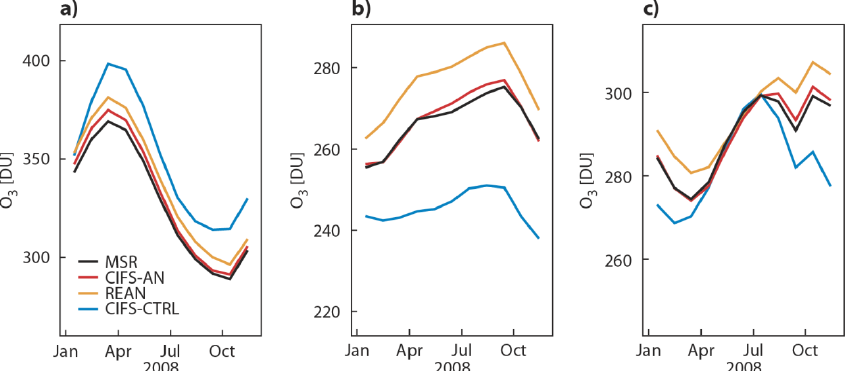
Figure 12. Time series for 2008 of the mean TCO3 of CIFS-AN (red), CIFS-CTRL (blue), REAN (orange) and the multi sensor reanalysis (black) in DU averaged over the (a) NH extratropics (30–90 ◦ N), (b) tropics (30 ◦ S–30 ◦ N) and (c) SH extratropics (90–30 ◦